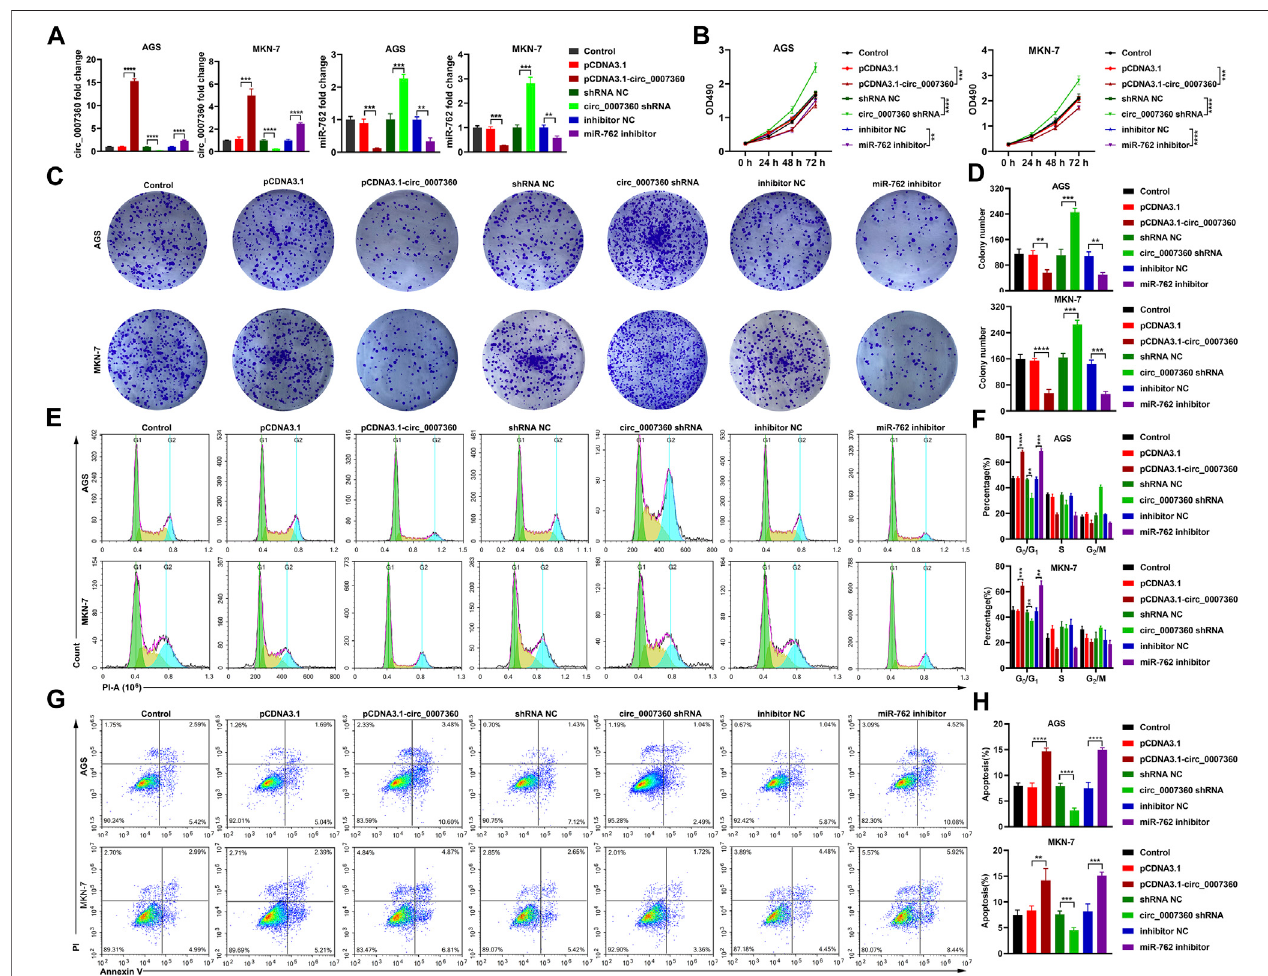
FIGURE 3 | Circ0007360 suppresses while miR-762 enhances cell survival. RT-qPCR quanti fi cation of circ0007360 or miR-762 expression with ectopic expression of circ0007360 , knockdown of circ0007360 , or miR-762 in AGS or MKN-7 cells. (B) MTT assay for detecting cell proliferation upon ectopic expression of circ0007360 , knockdown of circ0007360 , or miR-762 . (C , D) Representative images (C) and quanti fi cation (D) of colony formation results from cells with ectopic expression of circ0007360 , knockdown of circ0007360 , or miR-762. (E , F) Representative images (E) and quanti fi cation (F) of cell cycle analysis using fl ow cytometry of cells with ectopic expression of circ0007360 , knockdown of circ0007360 , or miR-762 . (G , H) Representative images (G) and quanti fi cation (H) of cell apoptosis analysis using fl ow cytometry of cells with ectopic expression of circ0007360 , knockdown of circ0007360 or miR-762 .